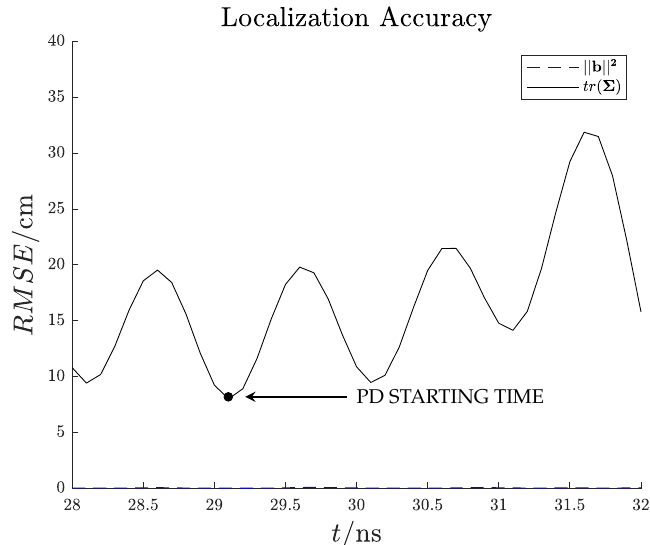
Figure 20. Test case 2. Estimated localization